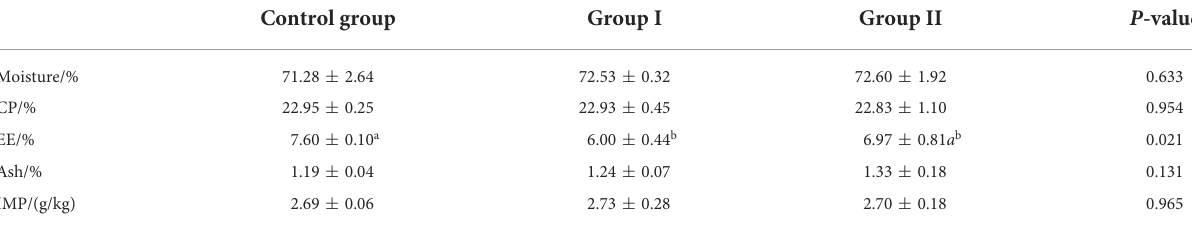
TABLE 6 Effect of dietary protein level on muscle nutrient contents and levels of inosinic acid in finishing pigs (fresh